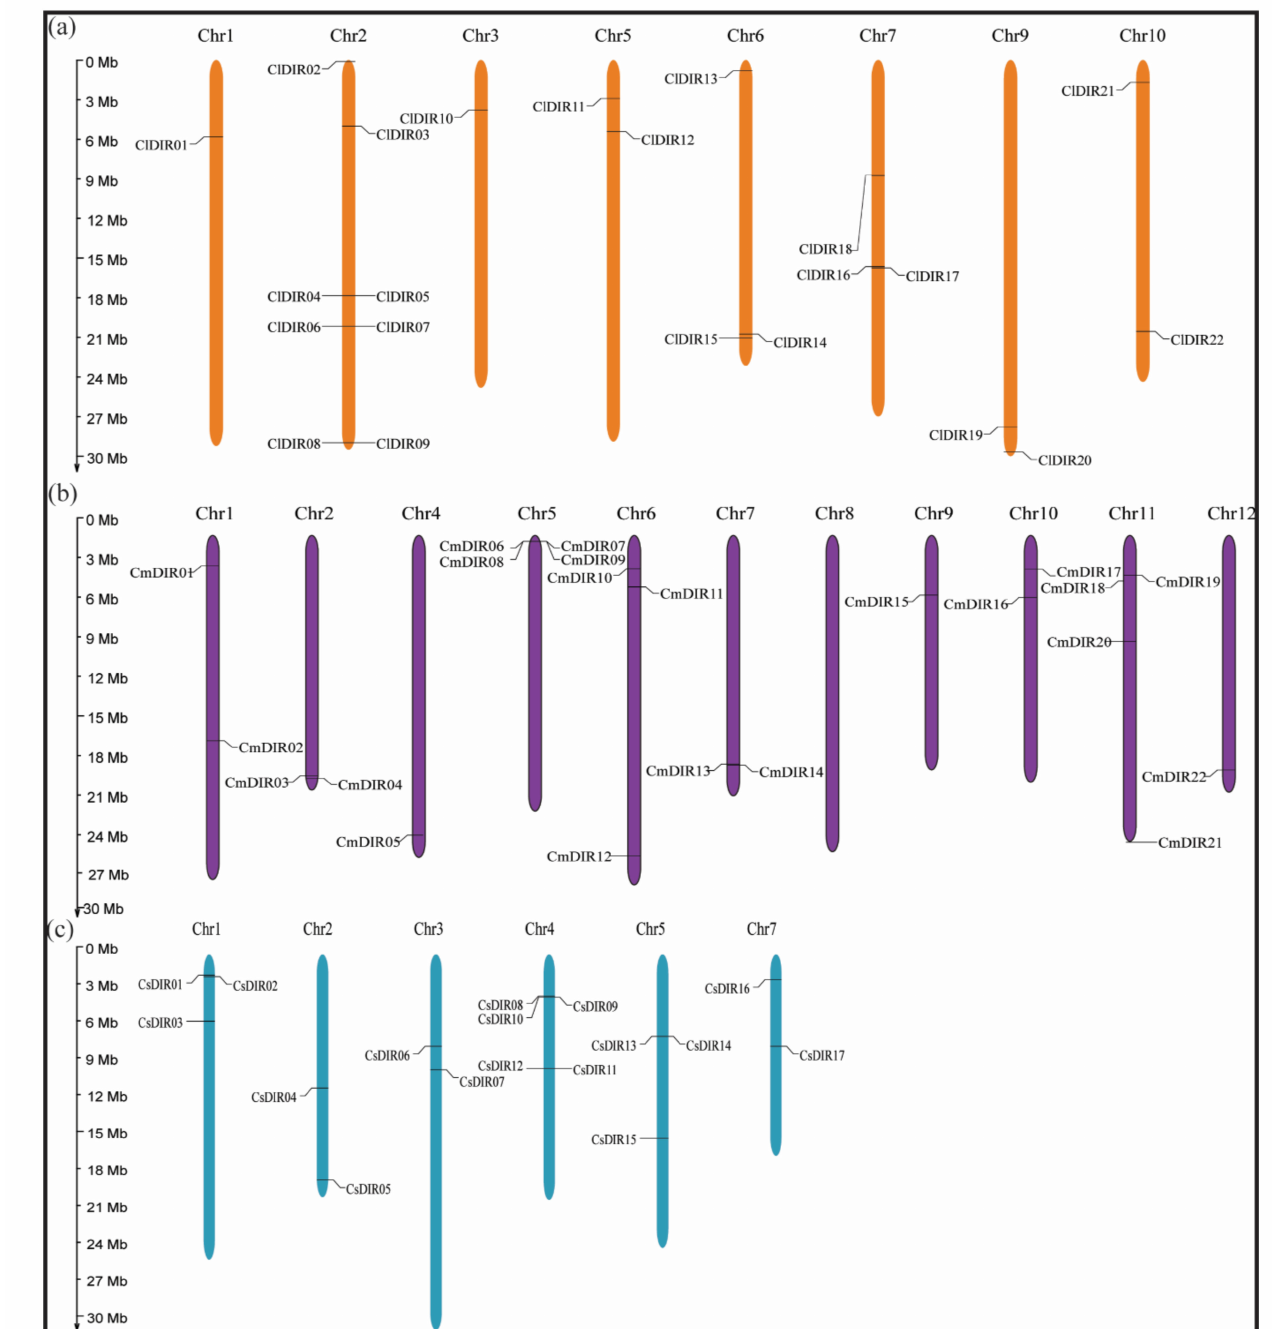
Figure 5. Chromosome mapping of dirigent genes on different cucurbit species. Chromosome numbers are demonstrated on each chromosome and scale is expressed in megabase (Mb). ( a ) Dirigent genes on chromosomes of watermelon ( Citrullus lanatus ). ( b ) Location of dirigent genes on melon ( Cucumis melo ) chromosomes. ( c ) Mapping of dirigent genes on cucumber chromosomes ( Cucumis sativus